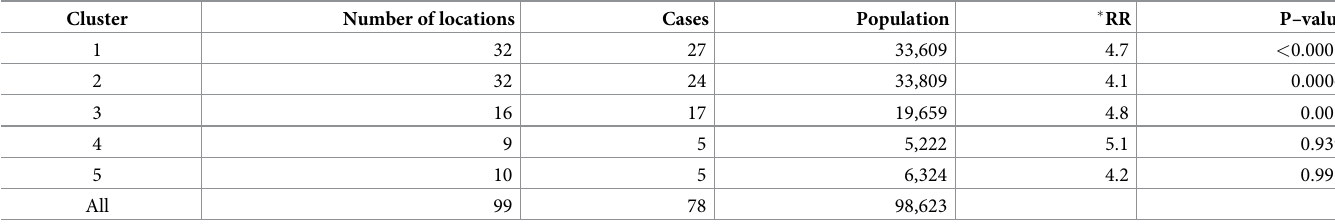
Table 2. Main clusters by Tolas in Bisfi and Benipatti, 2021–2022, India. Cluster